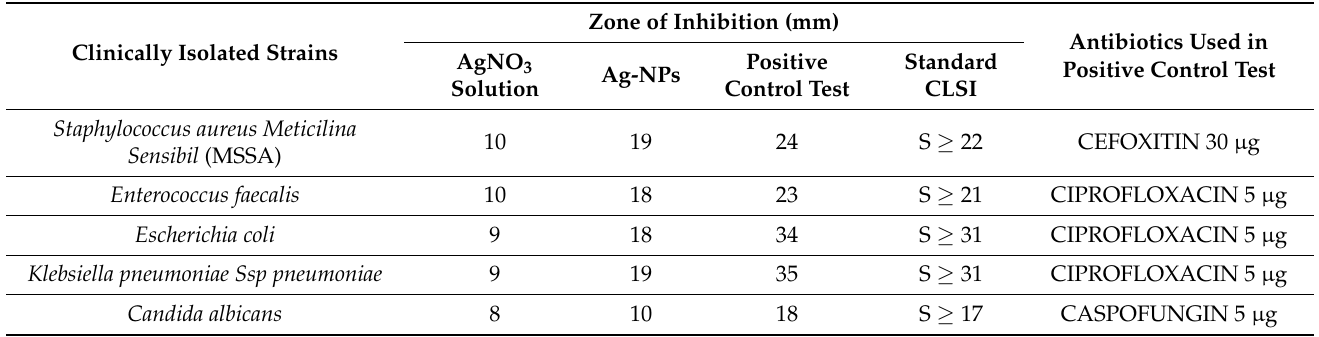
Zone of Inhibition (mm)